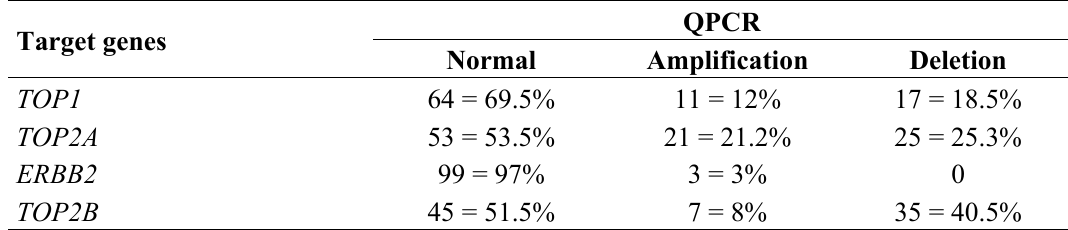
Table 3. Real-time semi-quantitative PCR analysis (QPCR) focusing on TOP1 , TOP2A , ERBB2 and TOP2B genes (results expressed in patient numbers followed by the